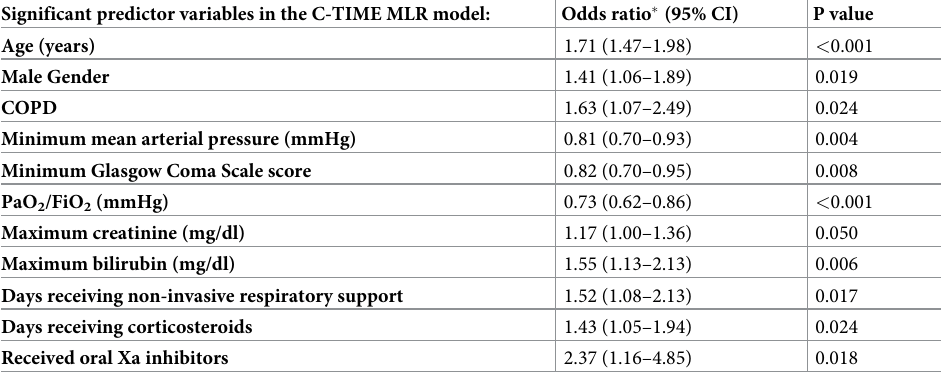
� Odds ratios are associated with a one standard deviation (SD) increment for continuous variables. Values used for SD: age: 13.7 years, MAP: 13.7 mmHg, PaO 2 /FiO 2 : 78.3 mmHg, creatinine: 1.9 mg/dl, bilirubin: 2.0 mg/dl, days receiving corticosteroids: 5 days; minimum Glasgow Coma Scale score: 3; days receiving non-invasive respiratory support before intubation: 5